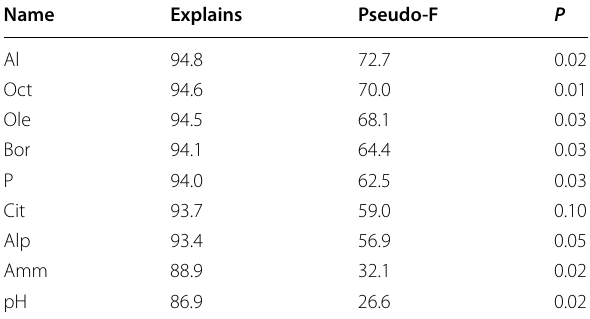
Al aluminum, P phosphorus, Ole oleamide, Cyc cyclohexene, Bor